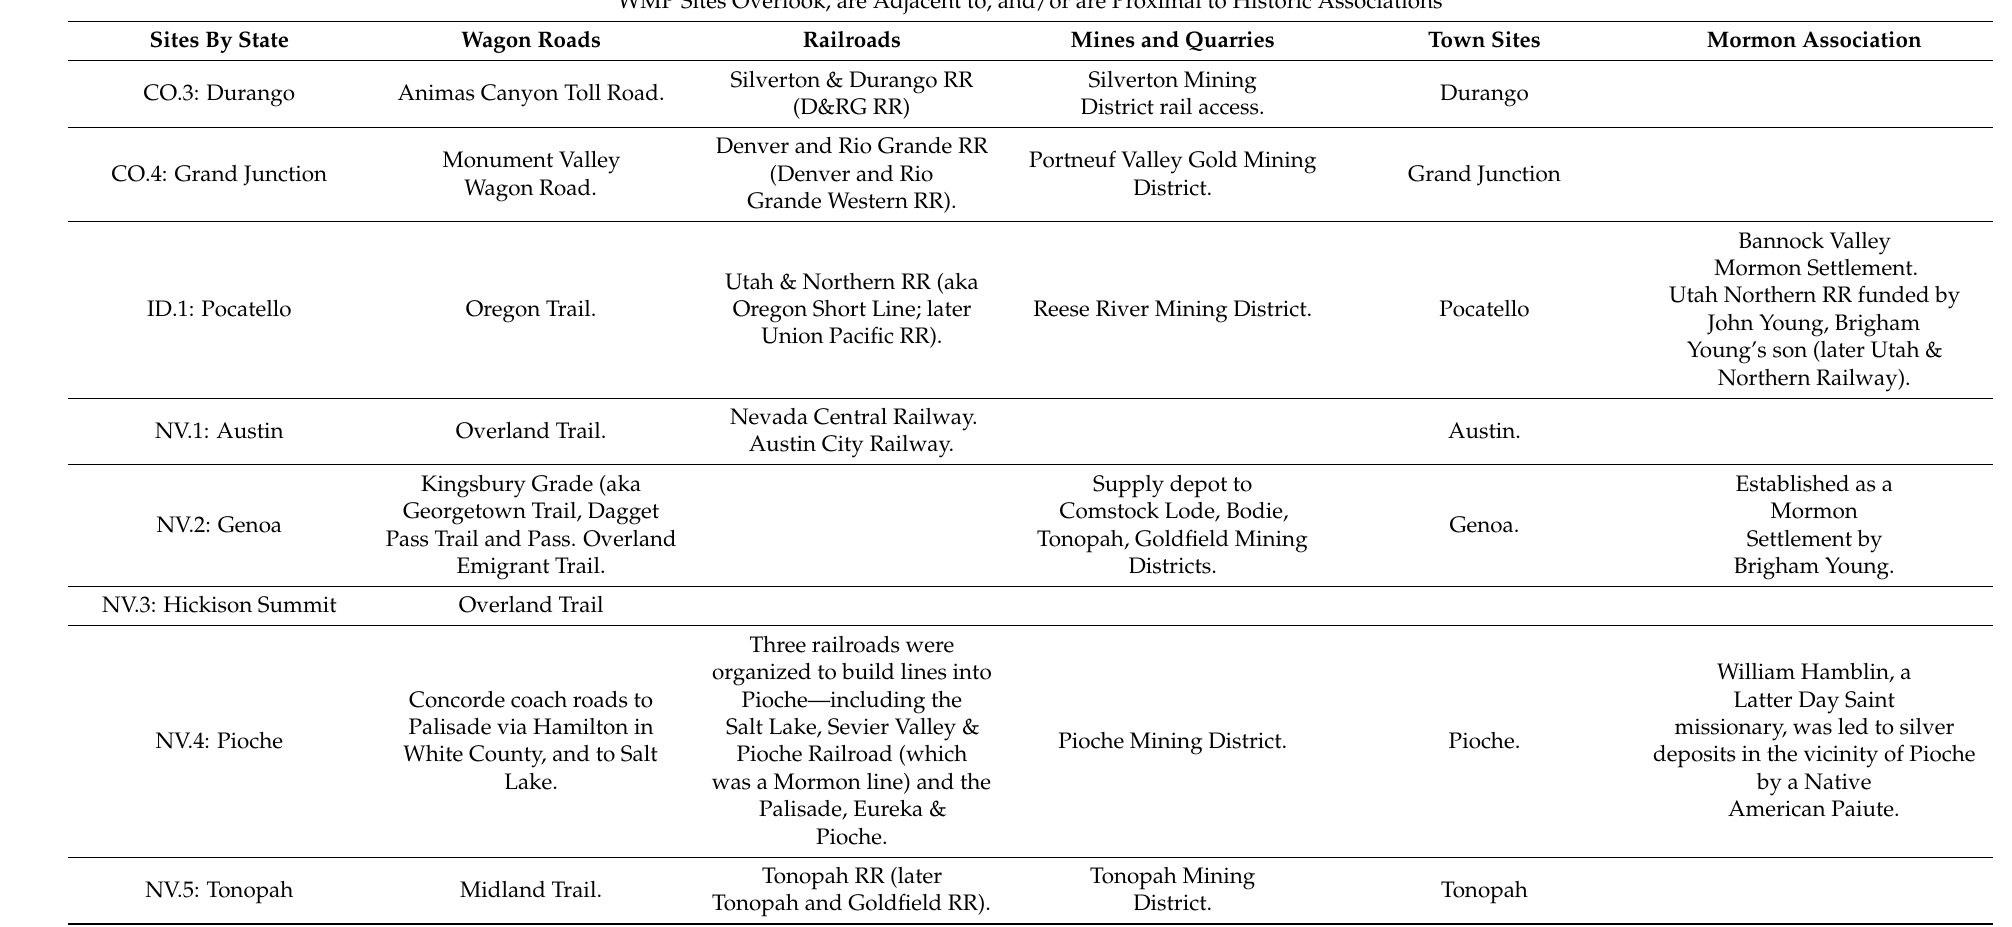
Table A2. Cont. WMP Sites Overlook, are Adjacent to, and/or are Proximal to Historic